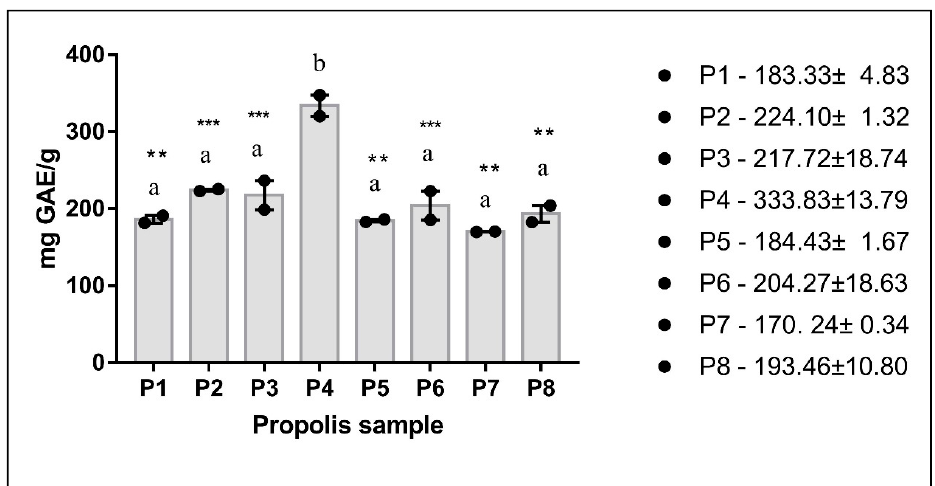
Figure 1. Total phenolic content of propolis samples P1-P8. Distinct letters on graph indicate significant differences among samples (** p < 0.01, *** p < 0.001, Bonferroni). (Data are expressed as mean ± SEM, b indicates significant difference in TPC from samples marked with a).